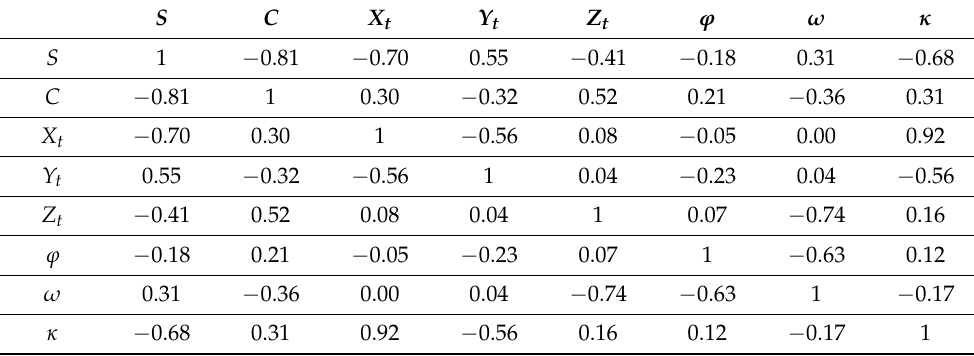
Table 16. The matrix of correlation coefficients of the unknowns for dataset